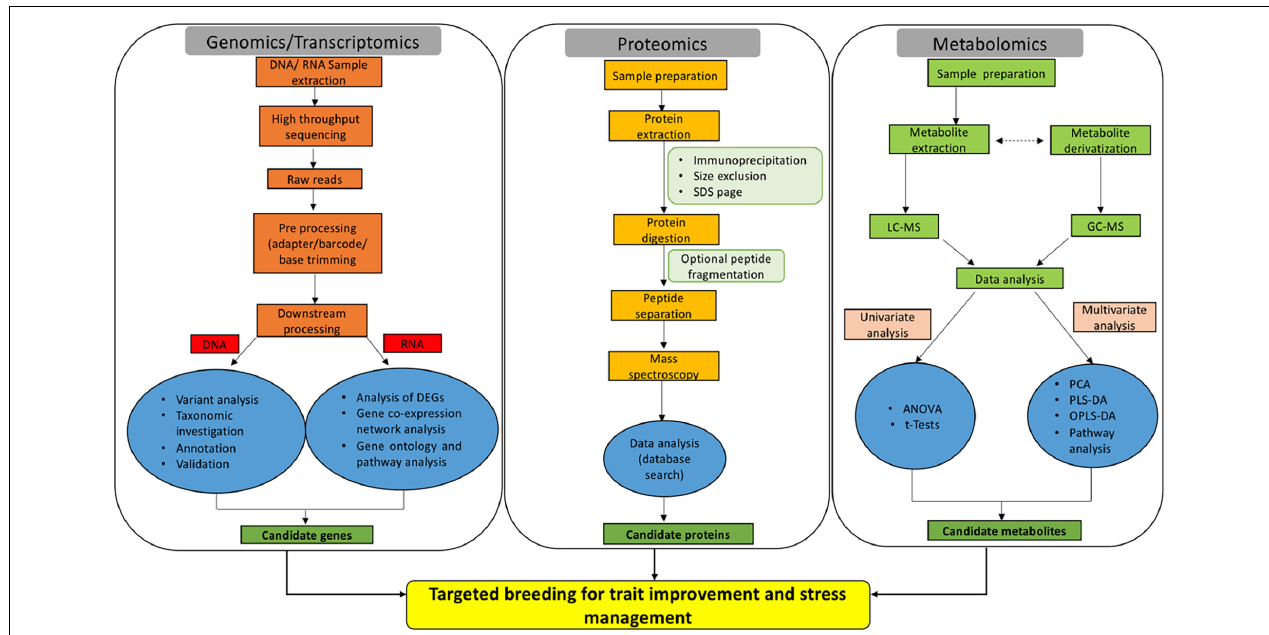
FIGURE 1 | Omics-based approaches are emerging as efficient tools for dissecting the key genes, proteins, and metabolites implicated in rice trait improvement and stress acclimation